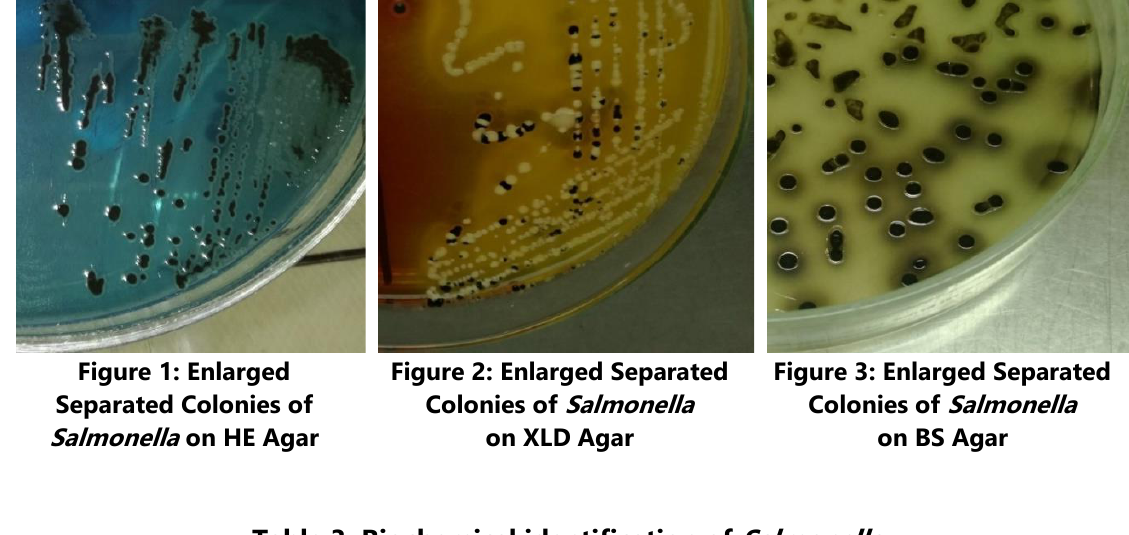
Table 3: Biochemical identification of Salmonella